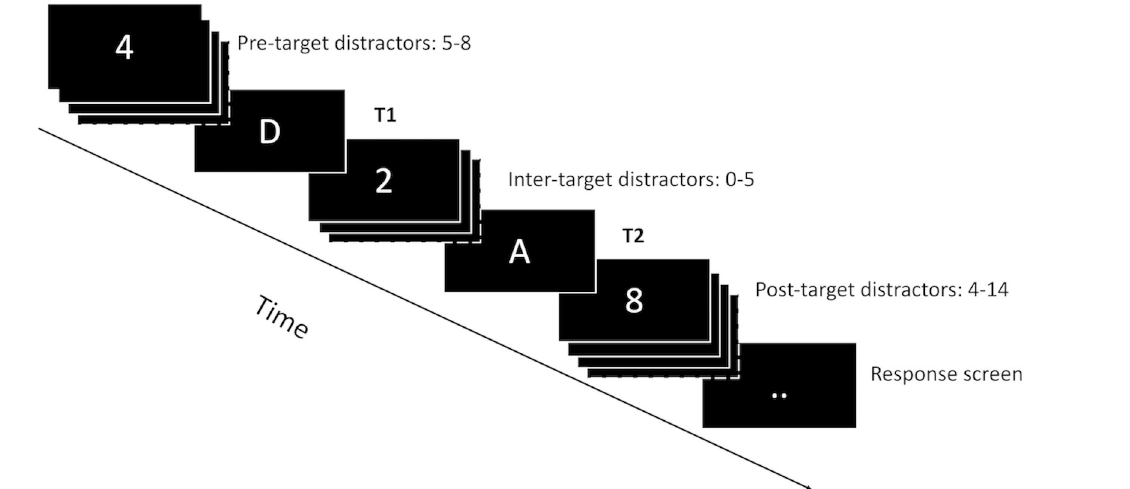
Fig 2. Schematic representation of a trial in Experiment